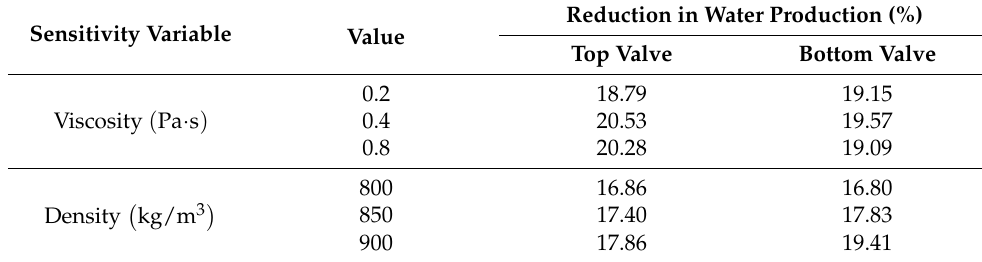
Table 5. Oil physical properties considered in the sensitivity